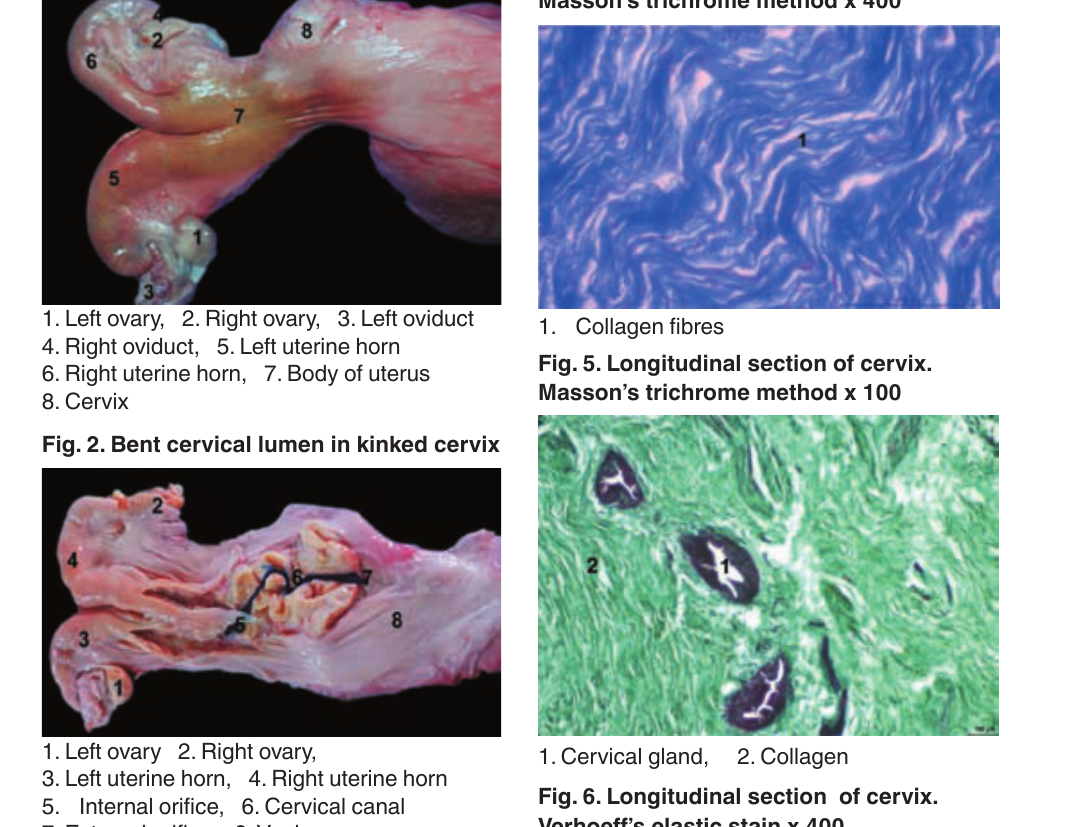
Fig. 1. External appearance of genitalia